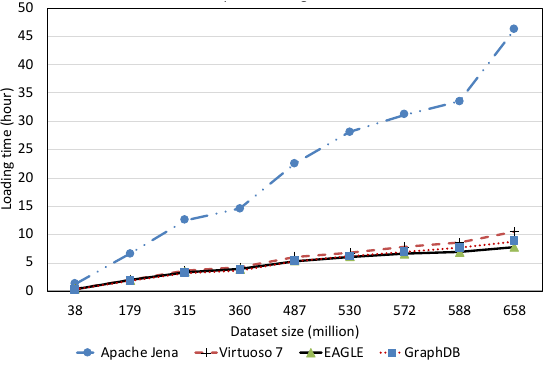
Figure 14. Spatial data loading